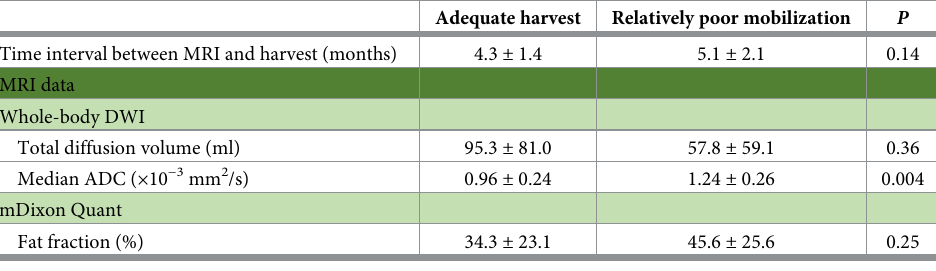
Table 2. Comparison of MRI-derived indices according to their response to mobilization.